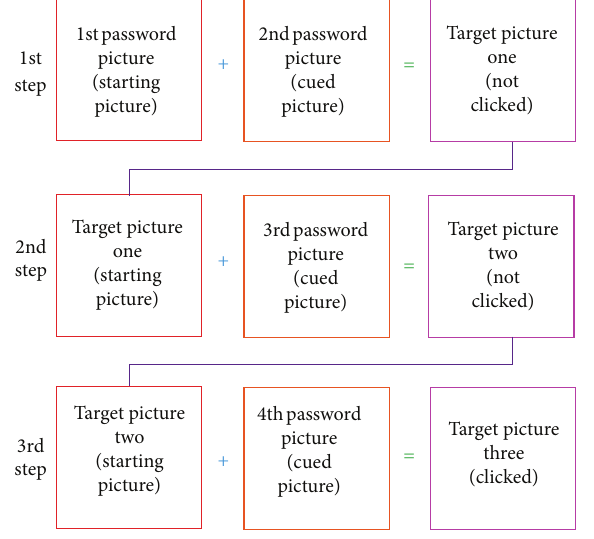
Figure 3: Relationship between starting, cued, and “target” pictures.